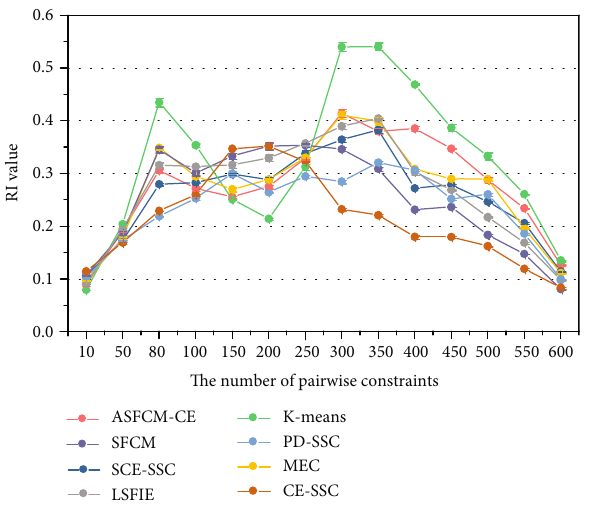
Figure 4: E ff ect of the number of pairwise constraints on the performance of the algorithm.